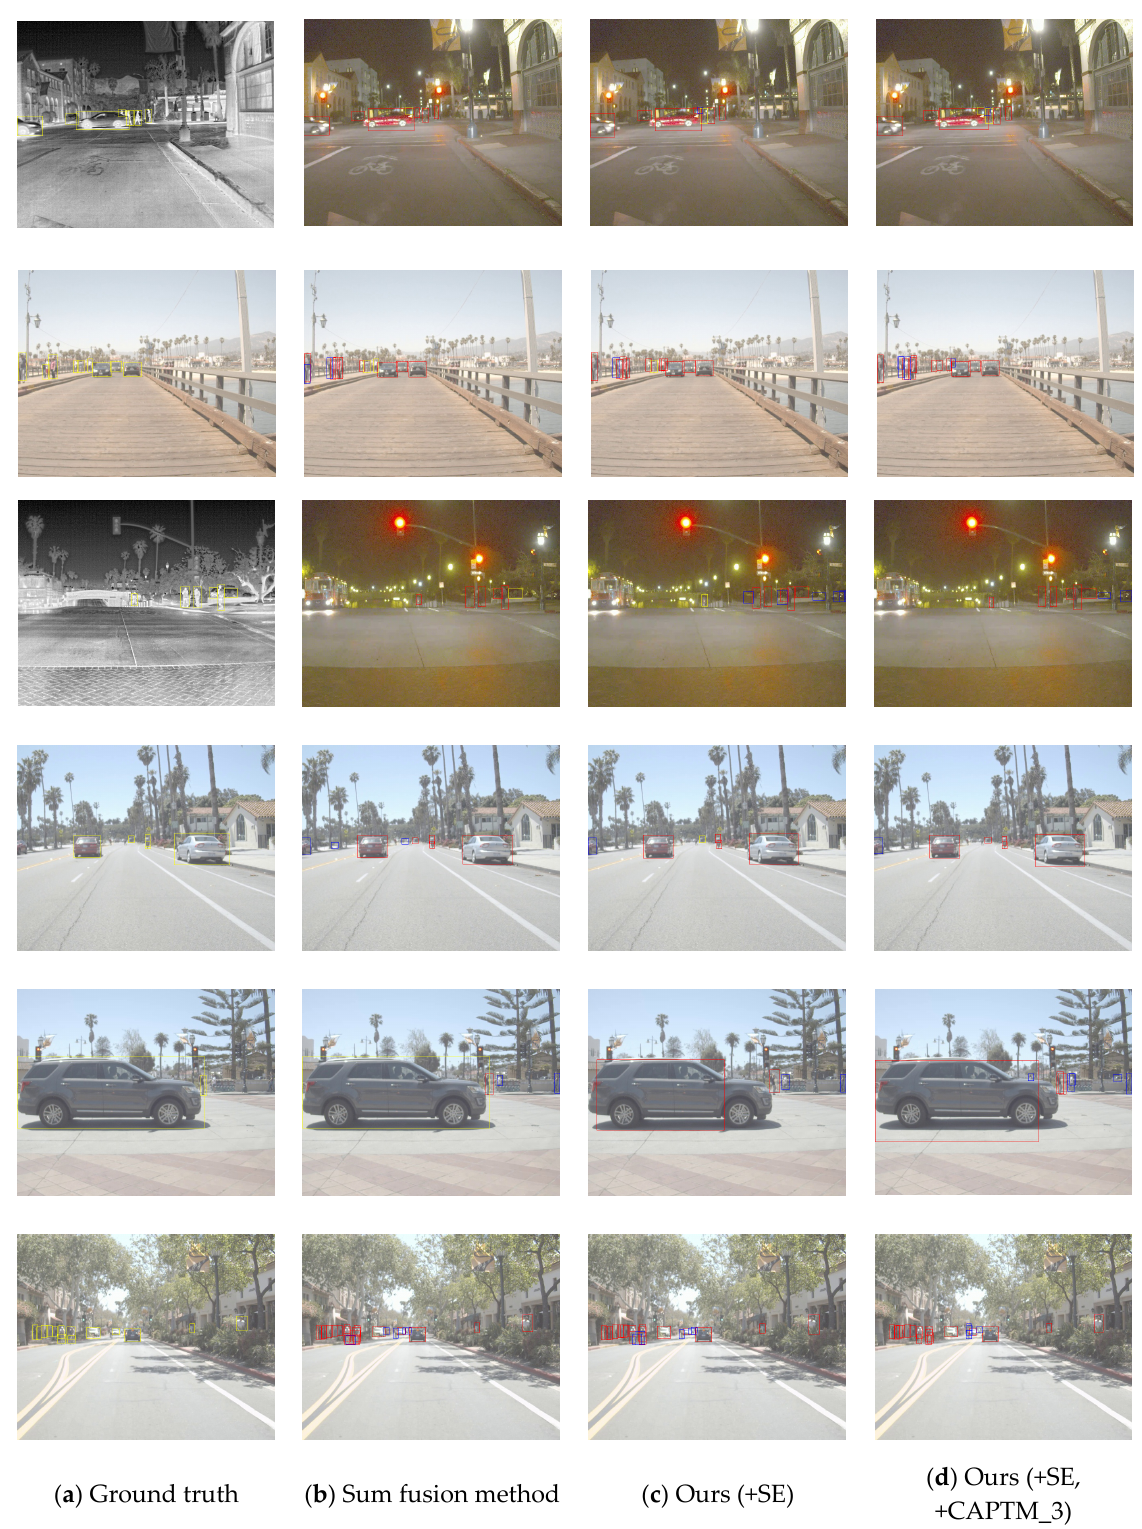
Figure 10. The detection results of different models. From left to right, each column represents the ground truth, sum fusion, the proposed model with only SE, and the proposed model with both SE and the CAPTM module. Furthermore, red, yellow, and blue respectively represent true-positive, false-negative, and false-positive results.